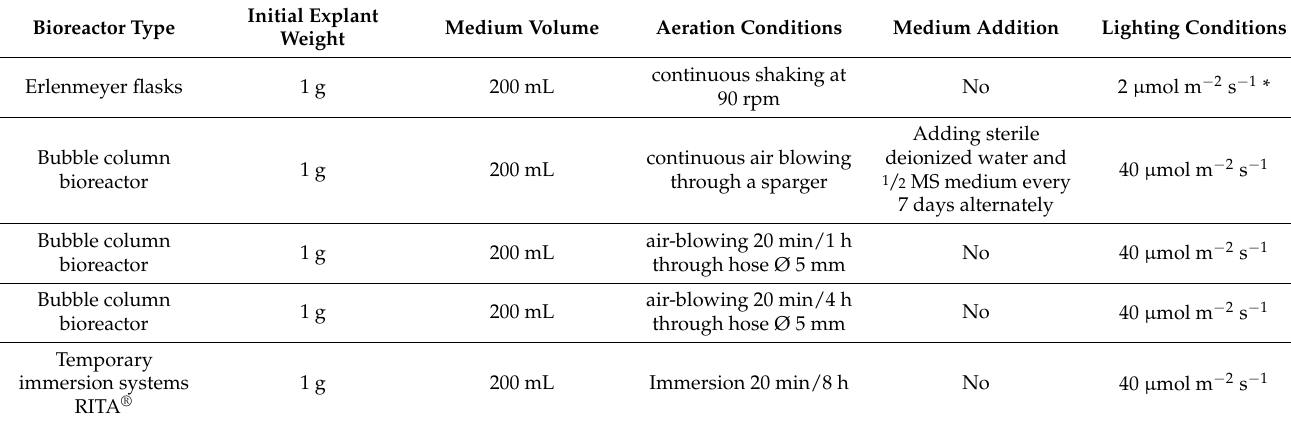
Table 3. Simple bioreactor types and the growth